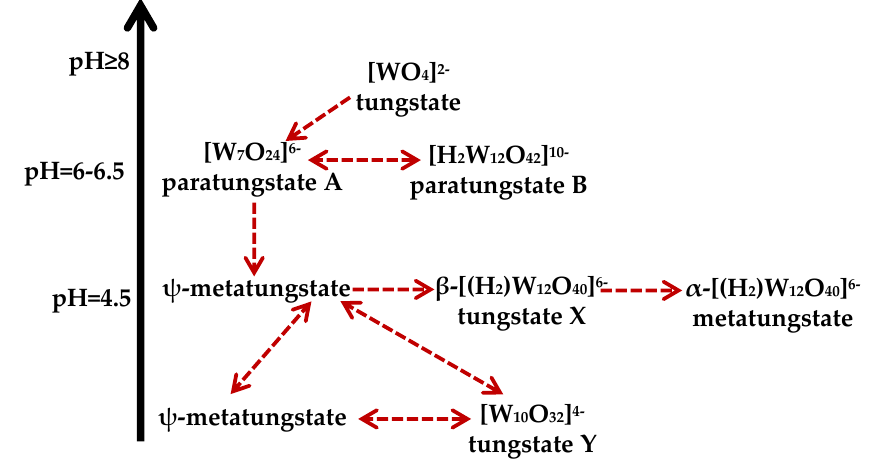
Figure 10. pH ranges corresponding to the stability of different polyoxotungstates. Adapted from Ref. [65], Copyright 2004, American Chemical Society.